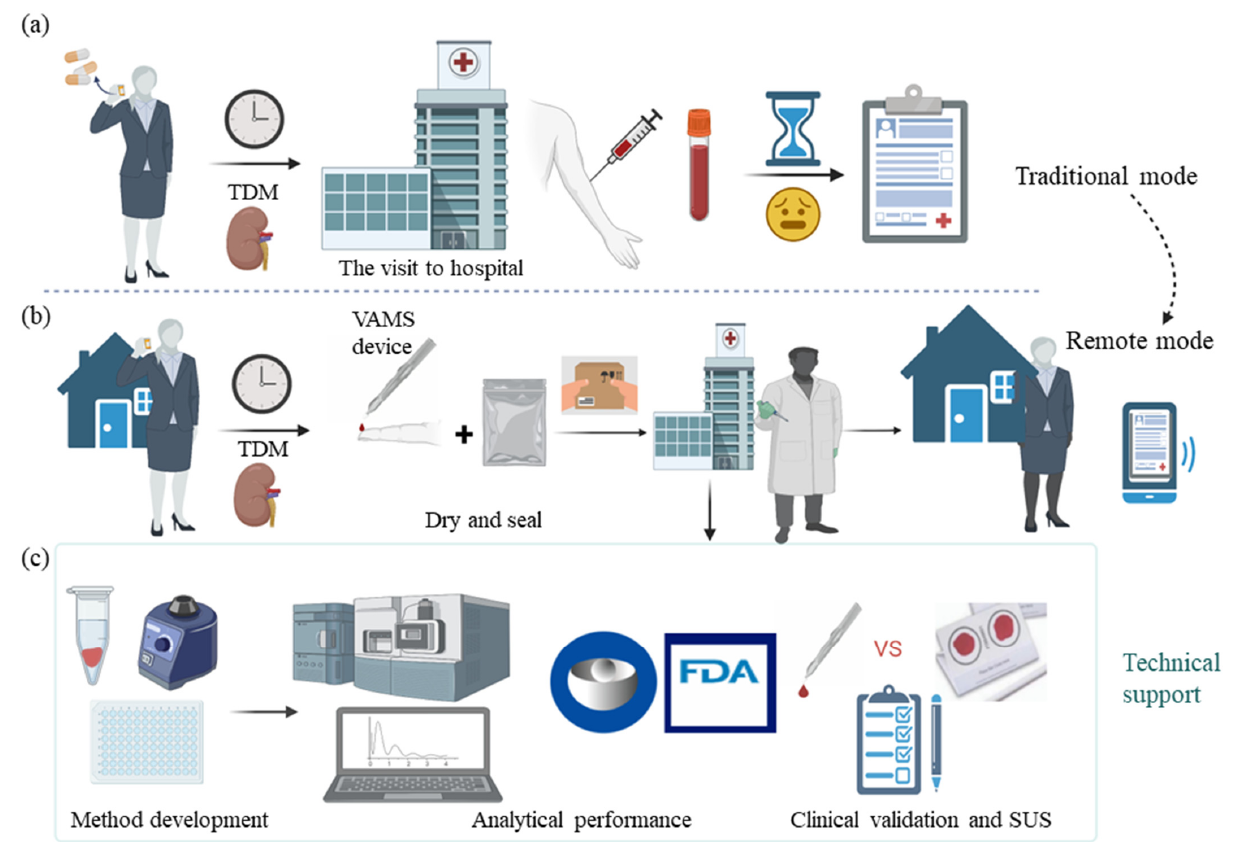
Figure 1. Schematic diagram of the research content. ( a ) the traditional mode of TDM and renal function monitoring in renal transplant recipients. They must go to the hospital regularly for venous blood sampling and wait hours to get their reports. It must be admitted that the visit to the hospital is time-, labor-, and cost-consuming. ( b ) It shows the desired remote monitoring mode if a VAMS device is applied. In this way, the recipients can conduct microsampling of fingertip blood at home, and then the VAMS filled with capillary blood will be dried, sealed, and mailed to the hospital for analysis. This